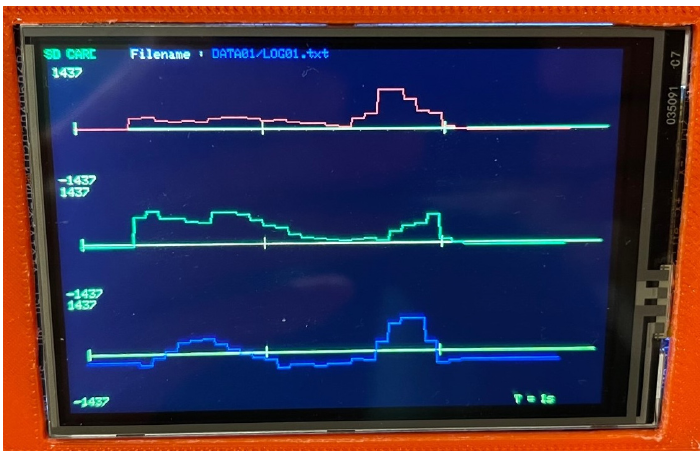
Figure 4. Sample diagram of the magnetic field.